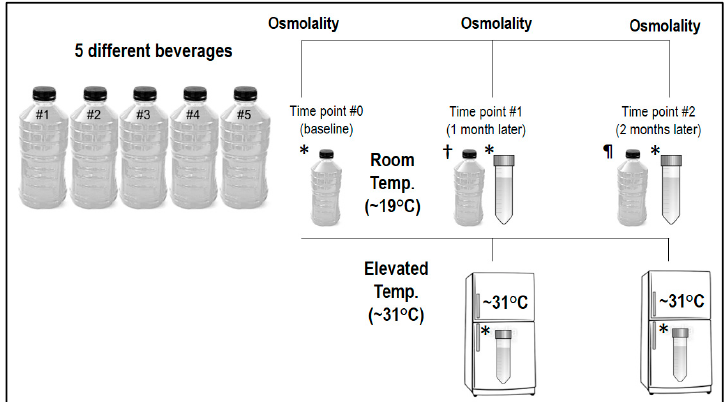
Figure 1. Schematic outlining the study methodologies for the third experiment; see text for further details. * The baseline bottle was aliquoted and subsequently stored for sampling at each time point. †,¶ A new bottle of each test beverage was also sampled at each time point.